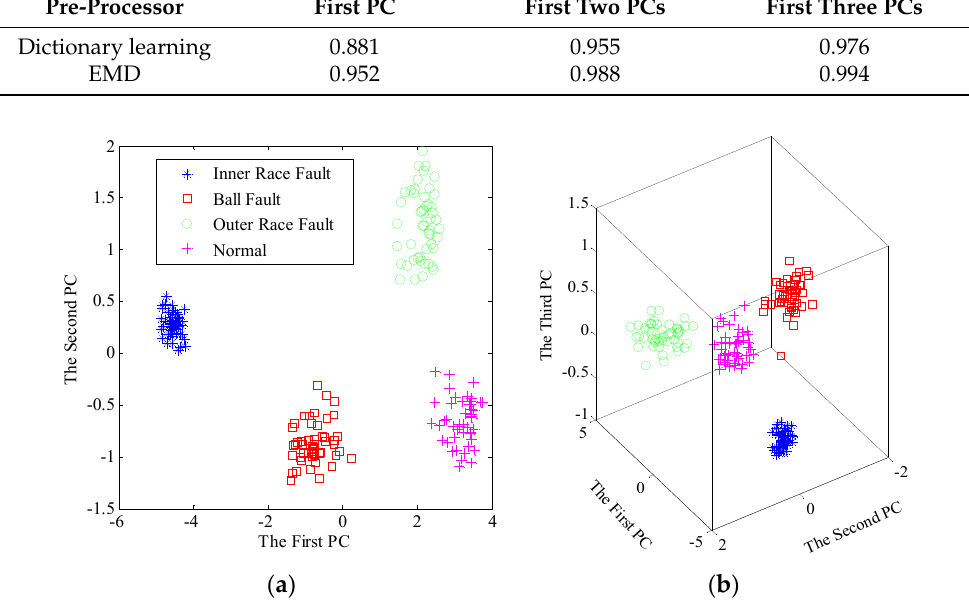
Table 2. Contribution rate of first few principal components in case 1.